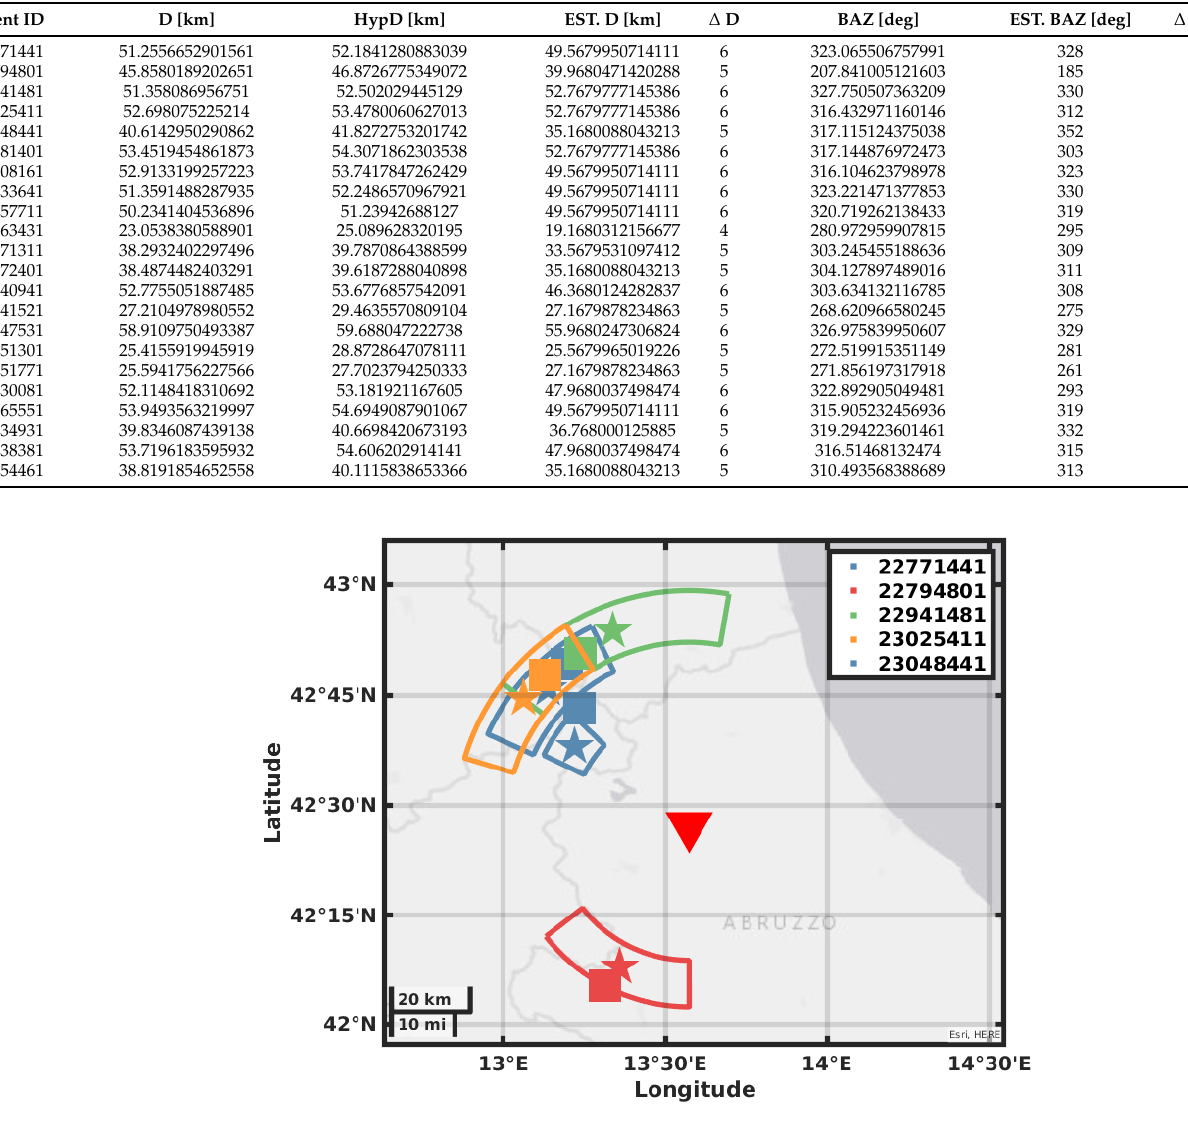
Figure 8. Map showing the GIGS station location, the earthquakes located by the INGV in solid squares, the earthquakes located using the GIGS station, and the relative location error in polar